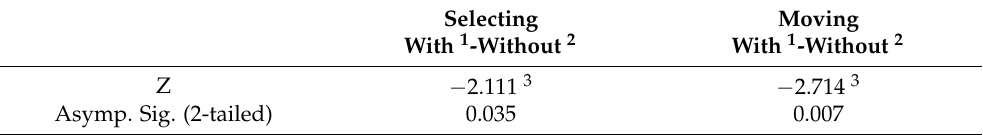
Table 5. Results of Wilcoxon signed-rank test of user satisfaction based on tasks. Selecting